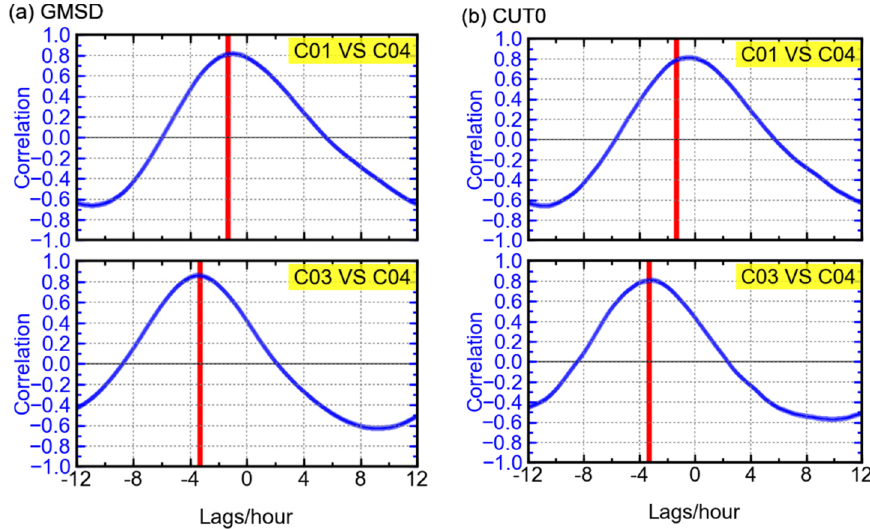
Figure 11. Cross-correlations between the GFIF combination time series (ten days) of different GEO satellites at the stations GMSD ( a ) and CUT0 ( b ), with the red vertical line indicating the local time difference between the two satellites.